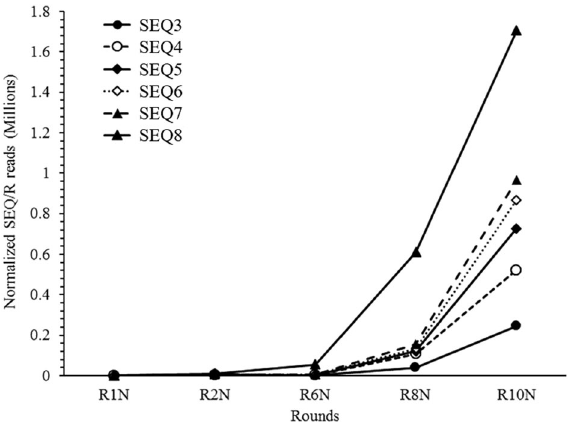
Figure 1. Illumina sequencing results. Normalized exponential increase of six highly enriched aptamer sequences among DNA pool over 10 rounds of the enrichment cycles of SELEX. Normalized reads were calculated using the formula: (no. of aptamer sequence reads /total no. of reads) × 100/(% the aptamer sequence in